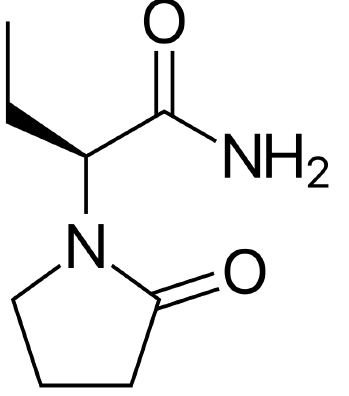
Figure 1. Levetiracetam chemical structure.